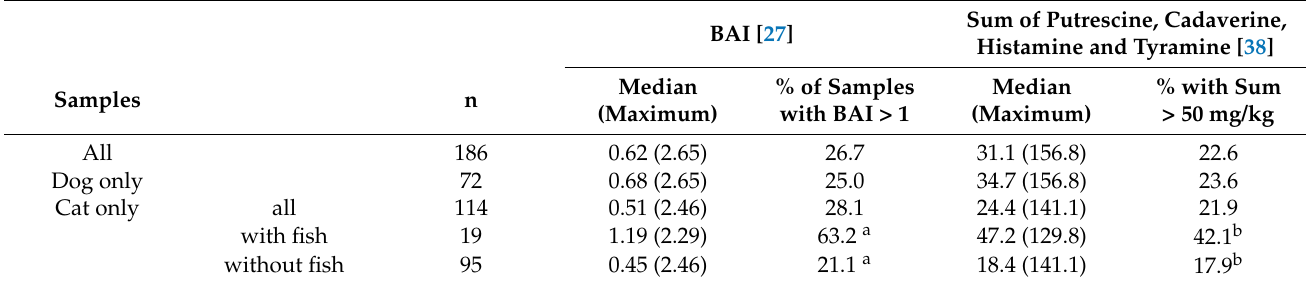
Table 2. Results for amine index values in canned dog and cat